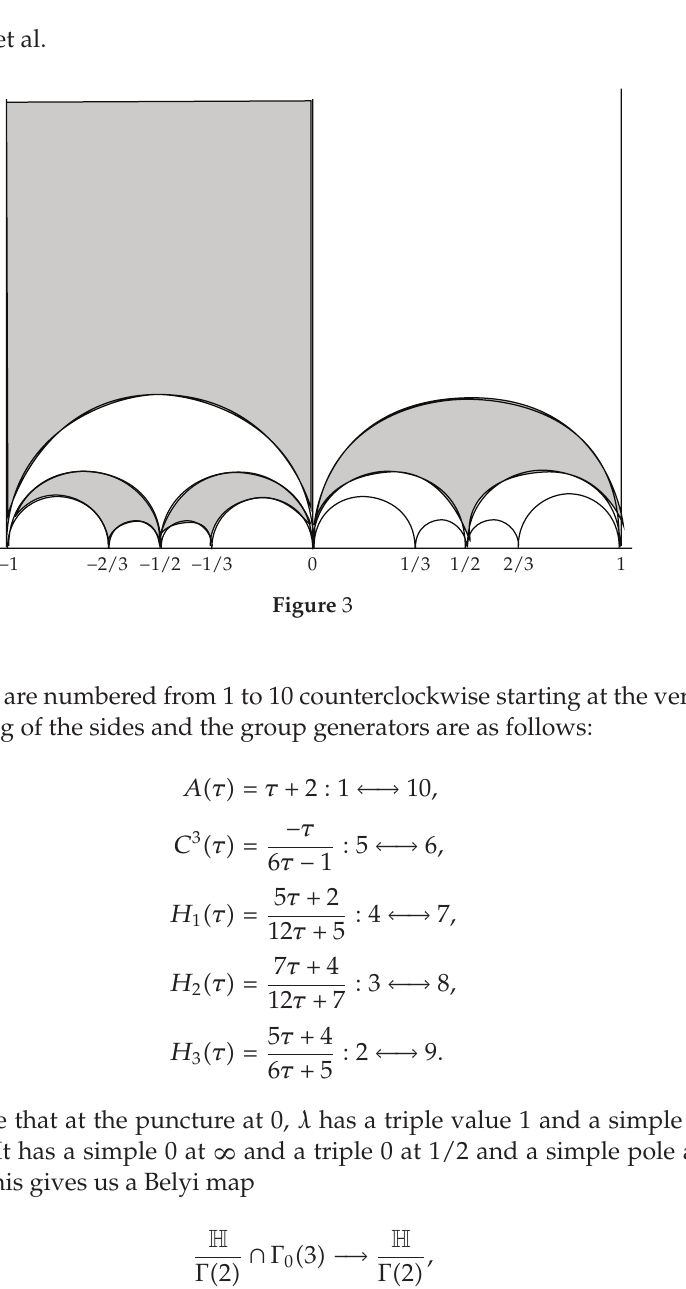
Figure 3 to a region bounded by arcs at − 3, − 2, − 3 / 2, − 1, 0, 1, 3 / 2 , 2 , 3. The